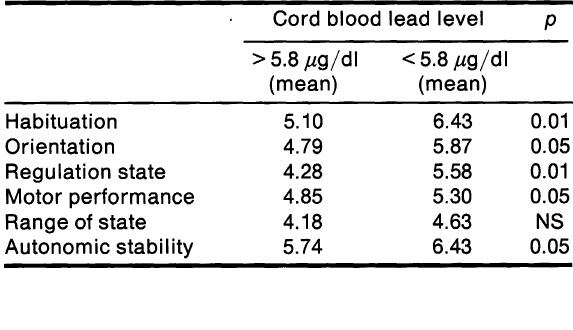
TABLE III. Correlation coeffiCient between lead